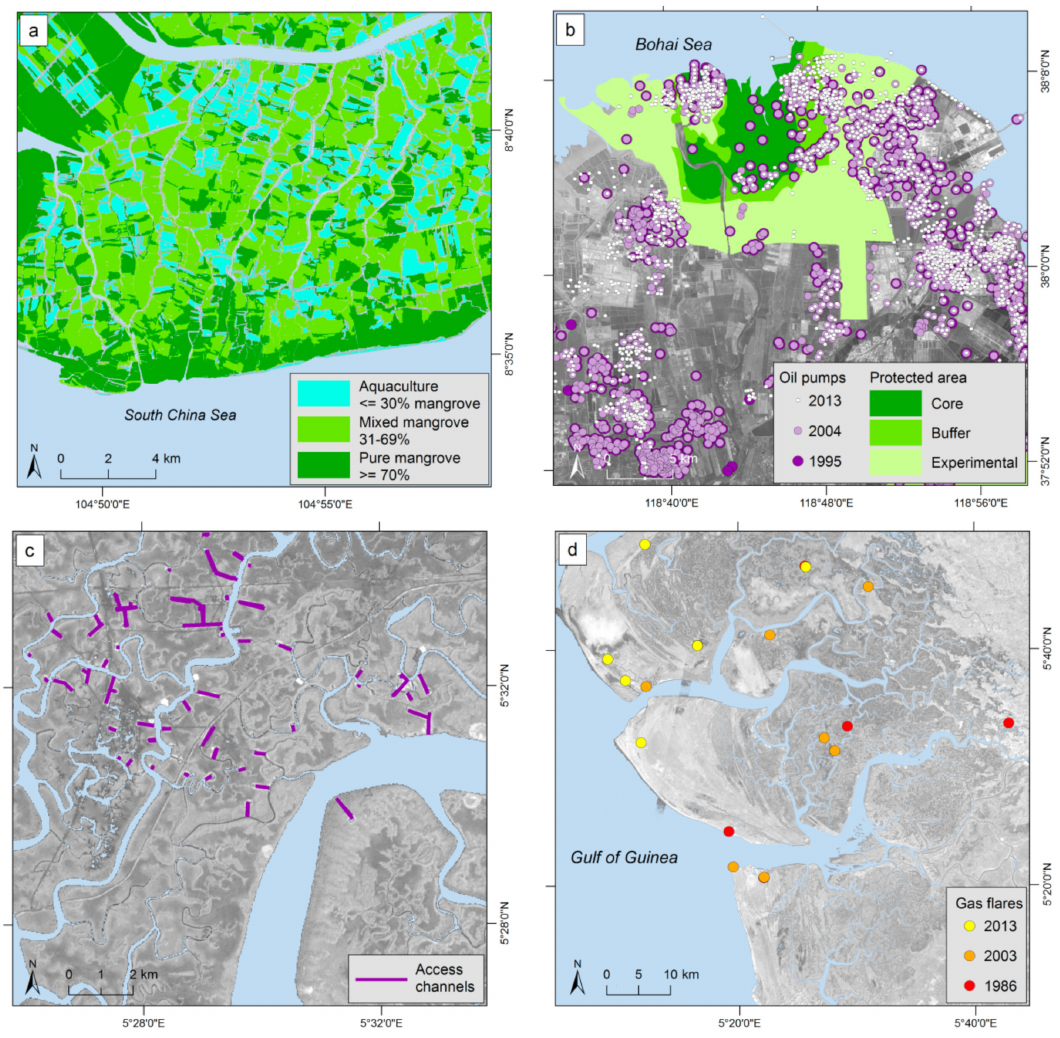
Figure 15. Examples for monitoring compliance. ( a ): mangrove percentage on a farmer’s land in Ca Mau Province, Mekong Delta, ( b ): spread of oil pumps in the northern Yellow River Delta Nature Reserve between 1995 and 2013, ( c ): spread of oil industry related access channels in the Niger Delta, ( d ): development of gas flares in part of the Niger